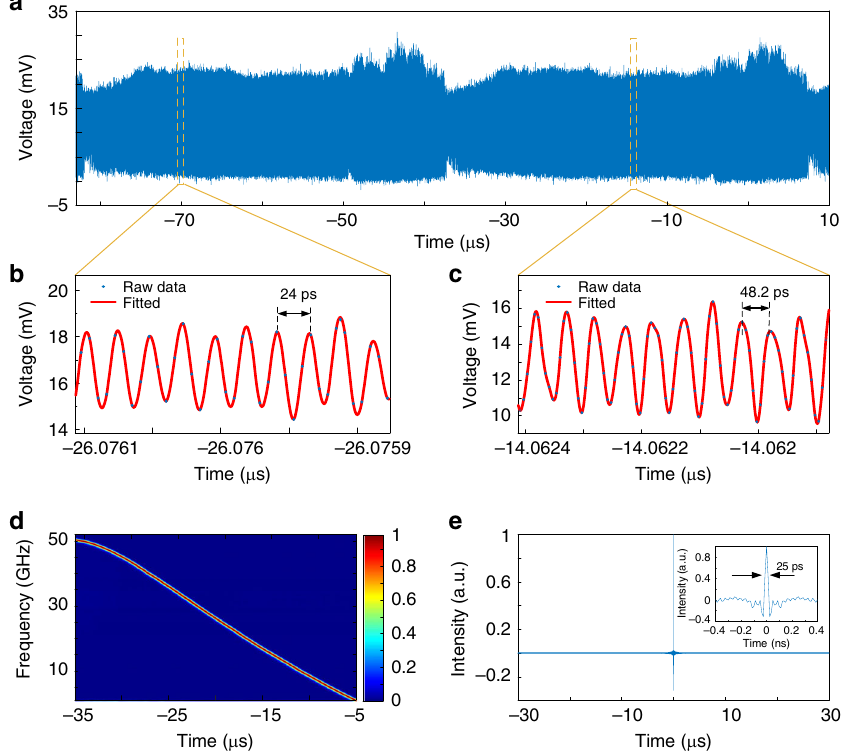
Fig. 4 Generated linearly chirped microwave waveform (LCMW). a Temporal waveform of the generated LCMW with a positive chirp rate by beating the frequency-chirped optical pulse with an optical carrier from an LD at a high-speed PD. The zoom-in views of the waveform are shown in ( b and c ). The blue dots in ( c ) are the originally recorded data and the red lines are the fi tted waveforms. d Spectrogram of the waveform shown in ( a ). e Compressed pulse by autocorrelation.